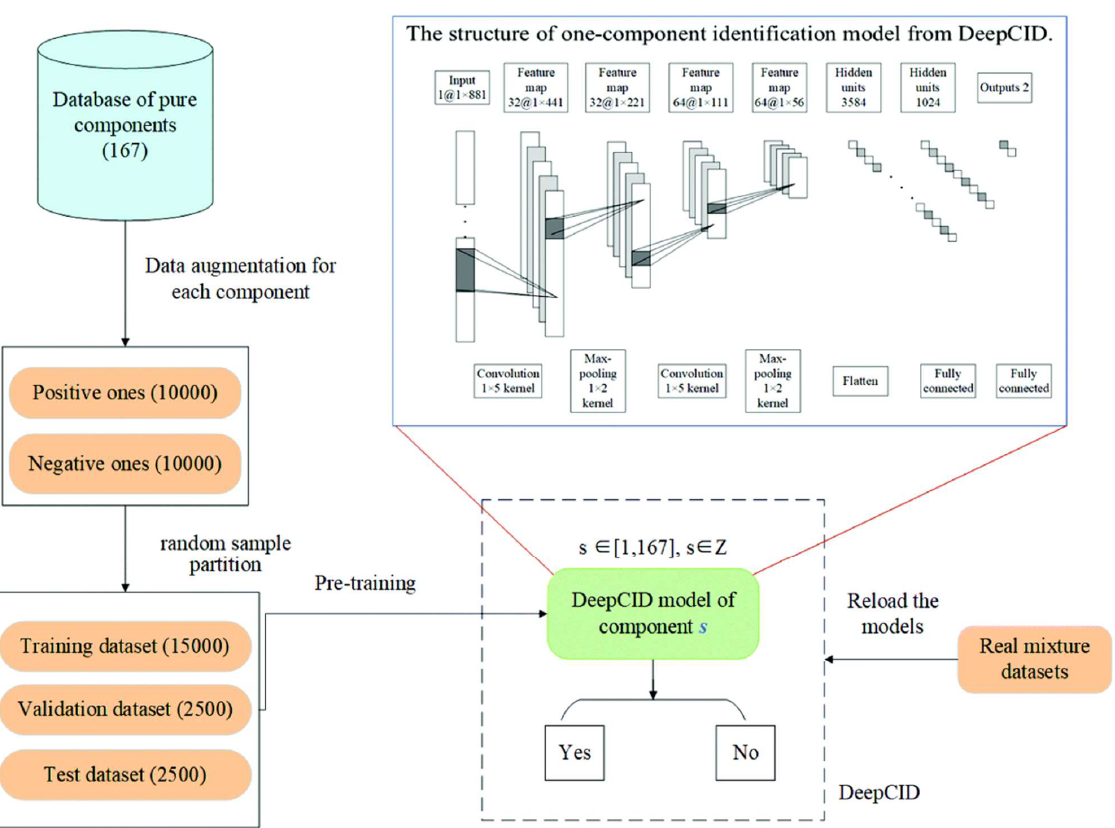
Figure 10. An example of using 1D CNN for Raman data classification (source: [42]). For classifying 167 different components, a set of DeepCID models with the same architecture were used. Each DeepCID model is a 1D CNN, which consists of four convolutional layers and two fully-connected layers. For training and evaluating each model, 20,000 samples were split into three datasets: training dataset, validation dataset, and test dataset.